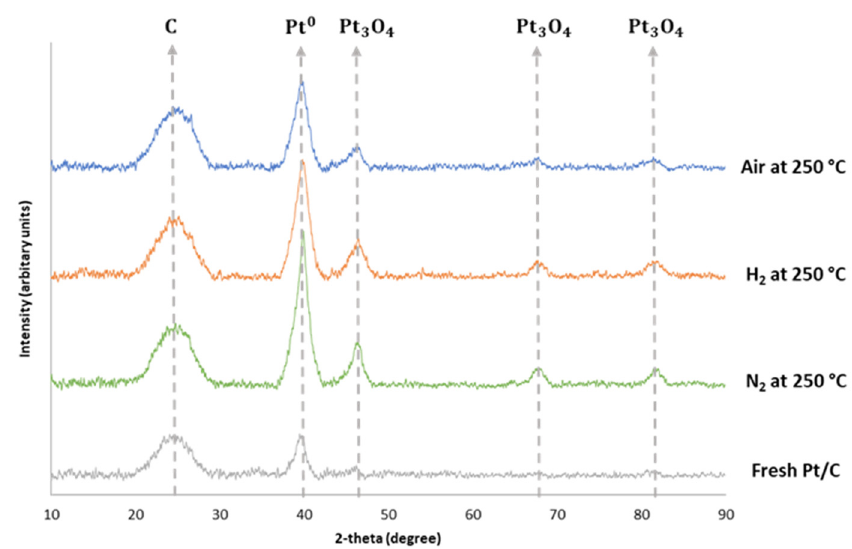
Figure 6. XRD of the fresh catalyst and used catalyst from the reactions with the highest propane yields under the three different reaction atmospheres.